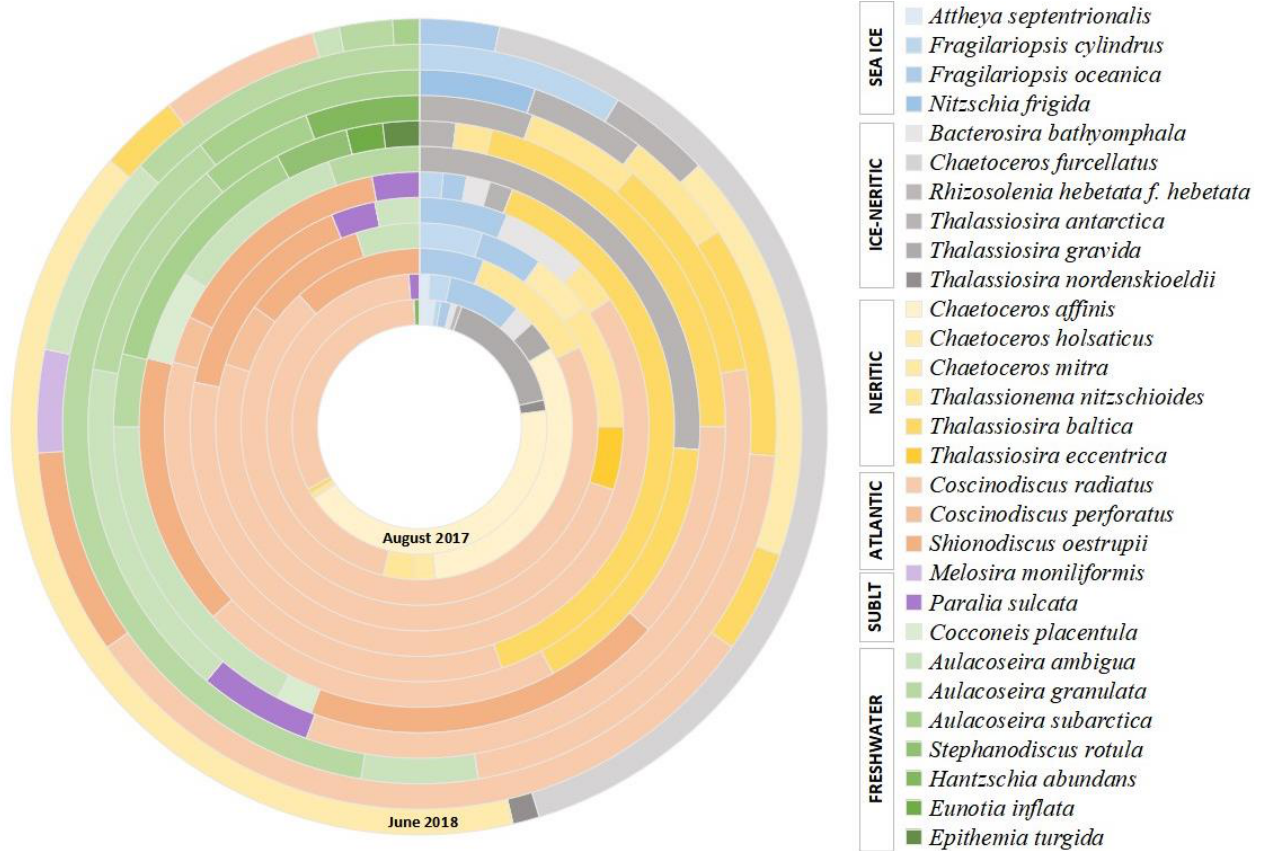
Figure 4. Diatom assemblage’s composition (%) in the sinking material of the East Barents Sea Depression. “SUBLT” means sublitto ral.